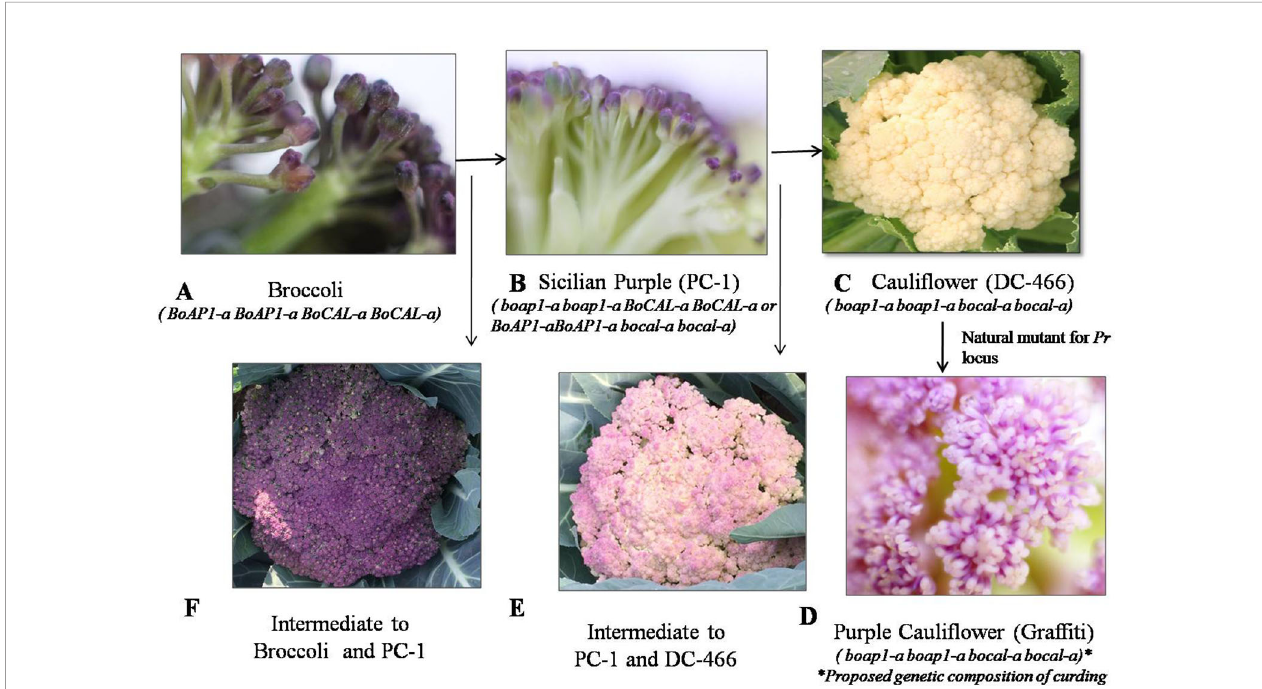
FIGURE 4 | Flower buds in knob texture of curd/heads. Broccoli type (A) , Sicilian purple ‘ PC-1 ’ type (B) white cauli fl ower ‘ DC-466 ’ (C) , purple cauli fl ower ‘ Graf fi ti ’ , (D) intermediate of ‘ PC-1 ’ and ‘ DC-466 ’ (E) , Intermediate of ‘ PC-1 ’ and broccoli (F)